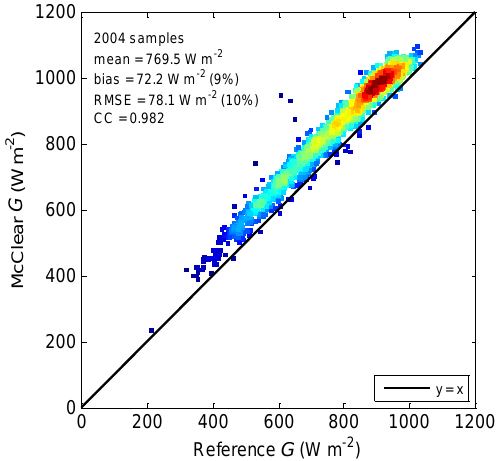
Figure 3. Scatter density plot between measurements of GHI and McClear estimates under cloud-free conditions at Matruh.